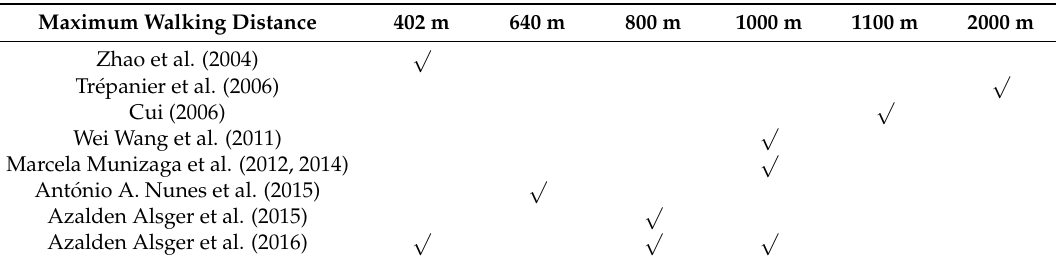
Table 3. Maximum walking distance used by the literature